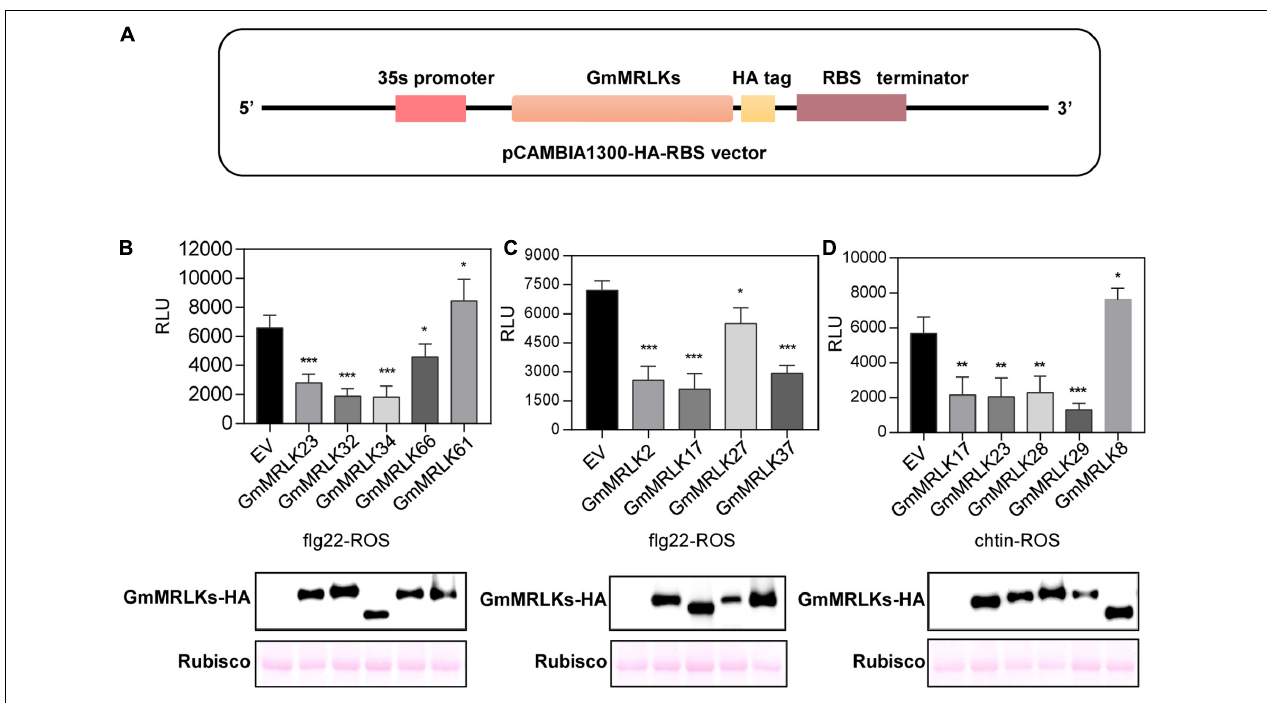
FIGURE 3 | GmMRLKs negatively regulate flg22- and chitin-induced ROS production in N. benthamiana plants. (A) Cloning of the GmMRLKs . The genomic sequences of GmMRLKs were cloned into the pCAMBIA1300-35S-HA-RBS vector, which were driven by 35S promoter, and followed by a HA tag and RBS terminator. (B,C) Effect of GmMRLKs on flg22-induced ROS burst. The indicated GmMRLKs were expressed in N. benthamiana plants by Agrobacterium -mediated transient expression for 2 days, and subjected to flg22-induced ROS examination. EV, empty vector. (Mean ± SD, n ≥ 6, Student’s t -test; * p < 0.05, *** p < 0.001). (D) Effect of GmMRLKs on chitin-induced ROS burst. The indicated GmMRLKs were expressed in N. benthamiana plants by Agrobacterium -mediated transient expression for 2 days, and subjected to chitin-induced ROS examination (mean ± SD, n ≥ 6, student’s t -test; ** p <